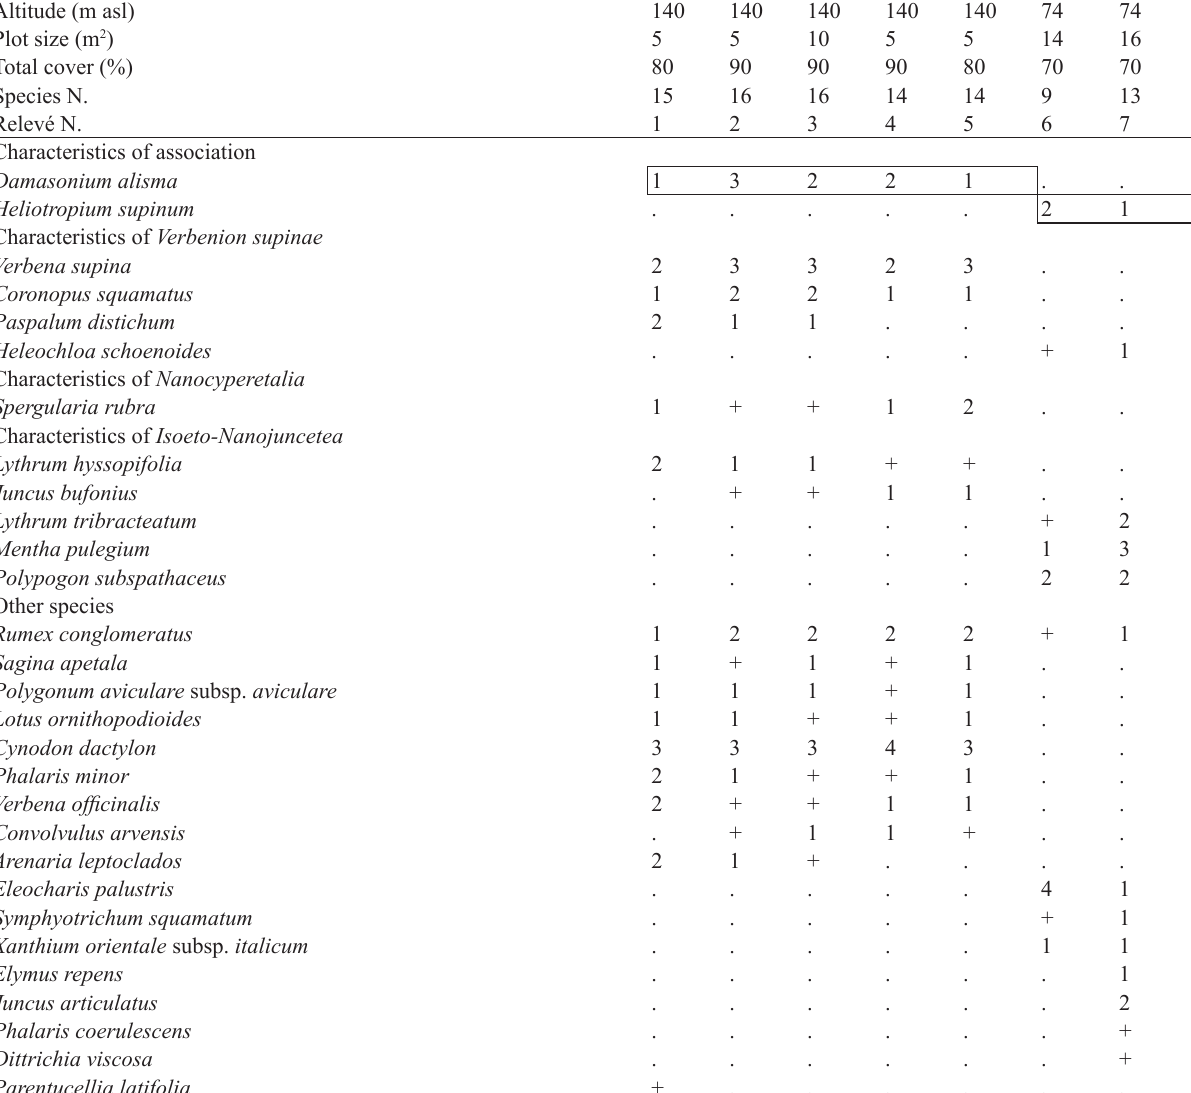
Localities: 1- 5: Iavorra Lake, Conversano, Bari, 07.04.2017; 6 -7: Lo Specchione, Brindisi,